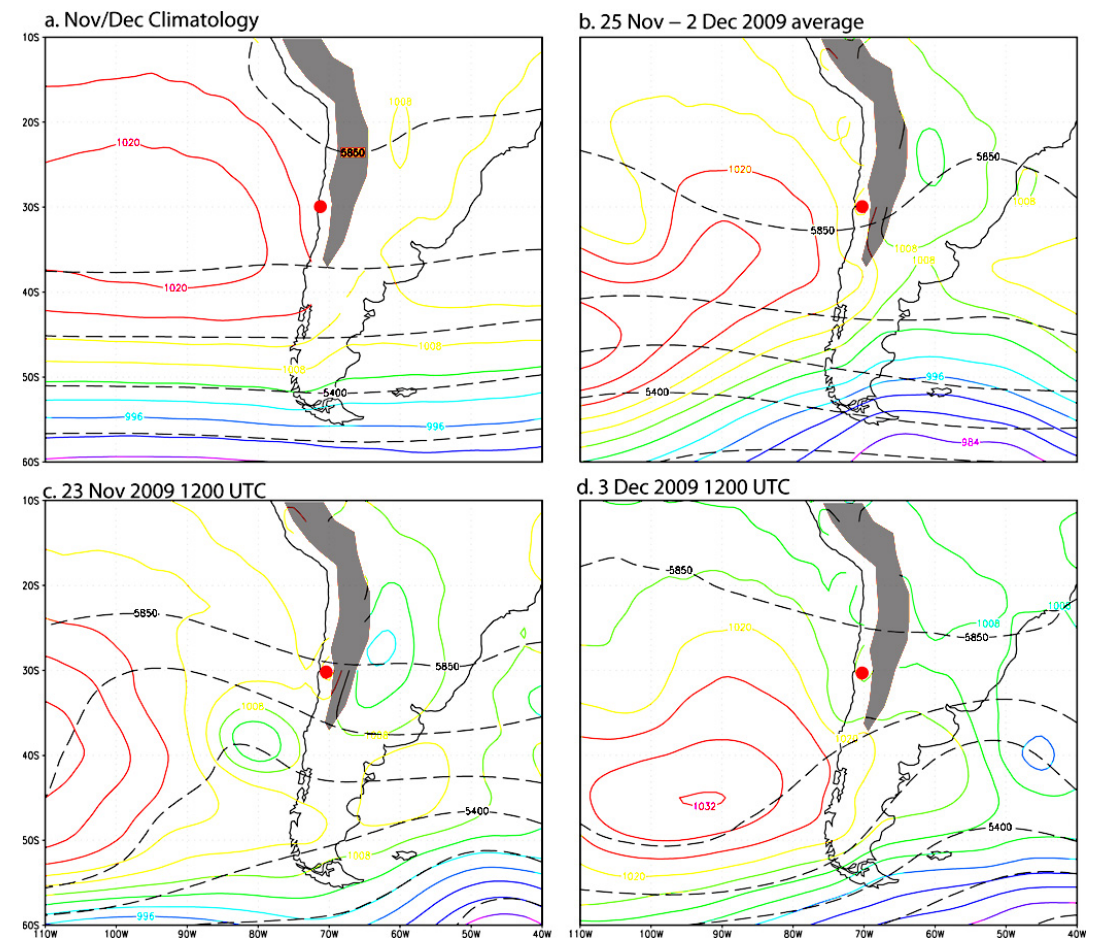
Fig. 6. Daily mean sea level pressure (solid, color lines every 4hPa) and 500hPa geopotential height (dashed, black lines every 150m) for selected dates and periods. Light brown area indicates terrain elevation in excess of 2000ma.s.l. Red dot indicates Tongoy area. (a) November–December long-term mean. (b) 25 November–2 December 2009 average (high-wind CUpEx period). (c) 23 November 2009 (first southerly wind relaxation during CUpEx, including brief periods of northerlies). (d) 3 December 2009 (second southerly wind relax- ation during CUpEx). Data source: NCEP-NCAR